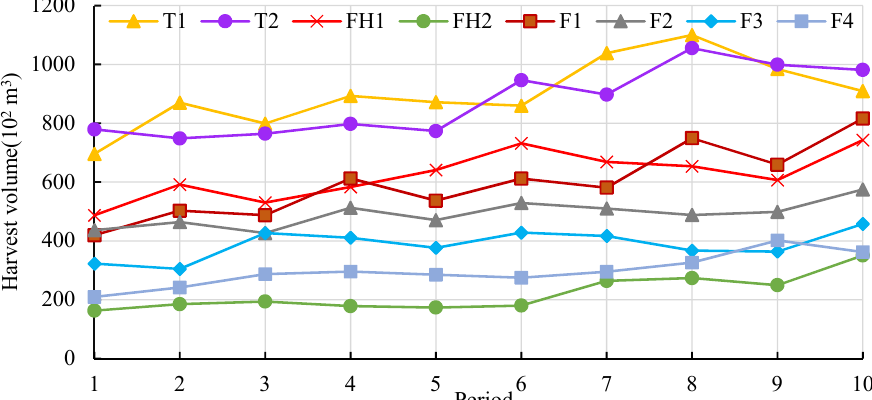
Figure 2. Timber production of Maoershan Forest Farm, China, over the time period of alternative management strategies: timber-oriented management strategy (TMS, scenarios T1 and T2), fixed selection of suitable habitat management strategy (FSSHMS, scenarios FH1 and FH2), and free selection of restricted suitable habitat management strategy (FSRSHMS, scenarios F1 to F4).